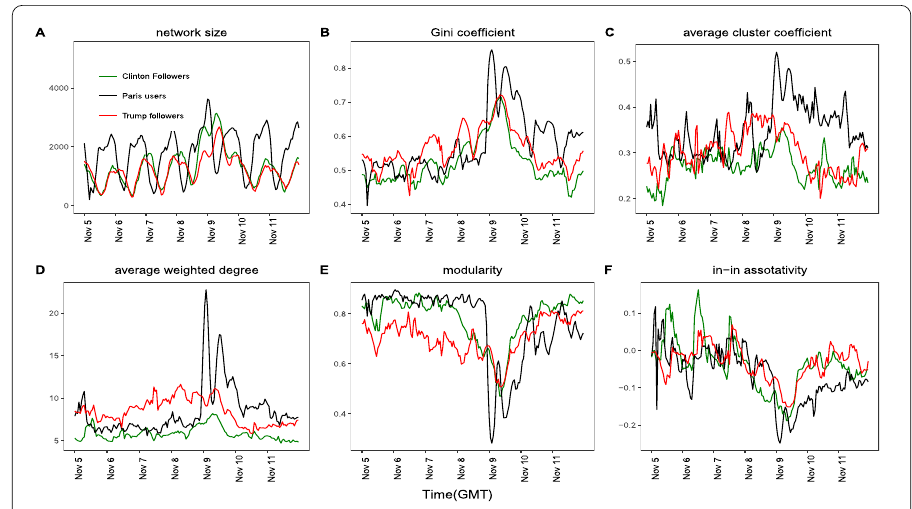
Figure 5 Comparison with non-emergency events. The collective attention dynamics during the 2016 US presidential election, starting from 2016-11-05 00:00 GMT. We also provide the Paris data from Figure 4 to offer a direct comparison, with the event day Nov. 13, 2015 (the Paris attacks) aligned with the election day Nov. 8,